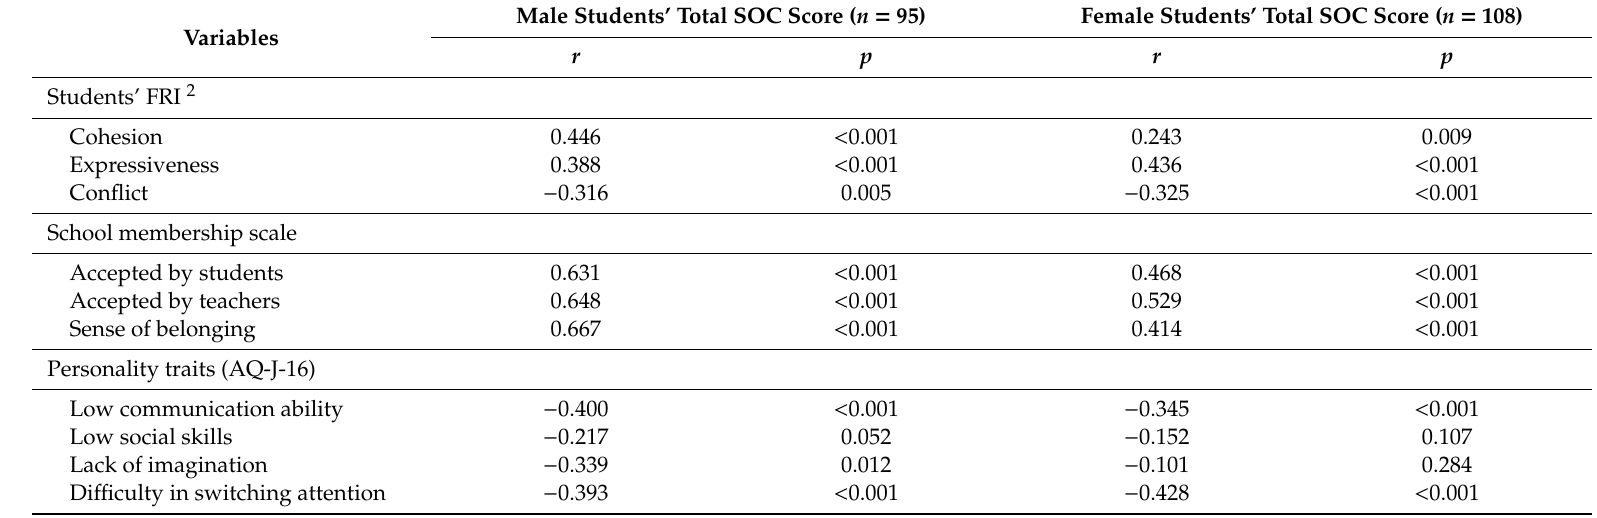
Table 4. Correlation between students’ SOC 1 (by gender) and other